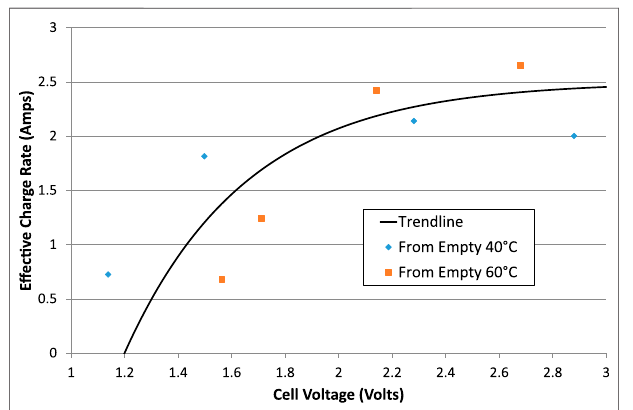
FIGURE 13 | Electrolysis tests starting with an almost-empty cell. Electrical energy input compared to calori fi c heat energy of gas output (HHV) and electrical energy